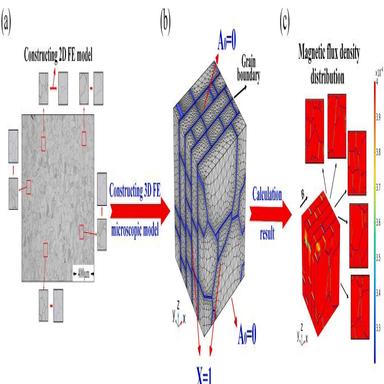
Process of constructing the 3D microstructure from 2D metallographs (a) microstructure diagram of ferrite with average grain size = 57 μm, (b) 3D FE micro-grain mode, (c) magnetic flux density distribution of 3D FE micro-grain mode when the relative permeability of grain boundary is 165.